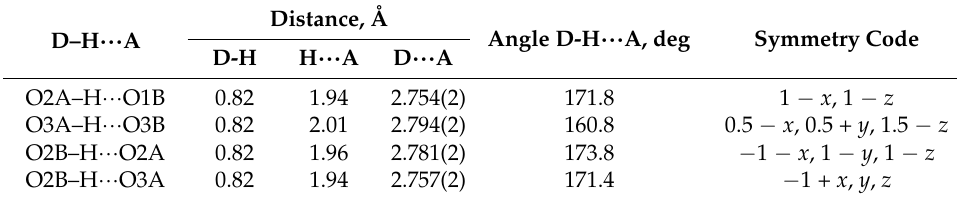
Table 3. H-bond parameters for compound 15